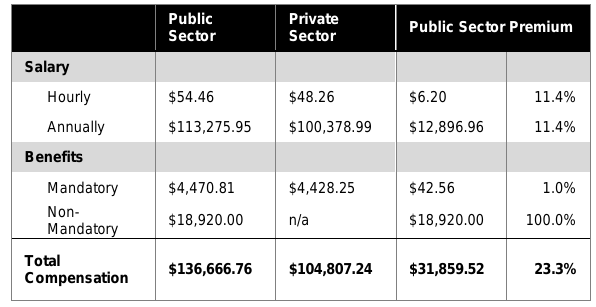
Table 1 : Comparison of total compensation for clinicians in the public and private sectors.